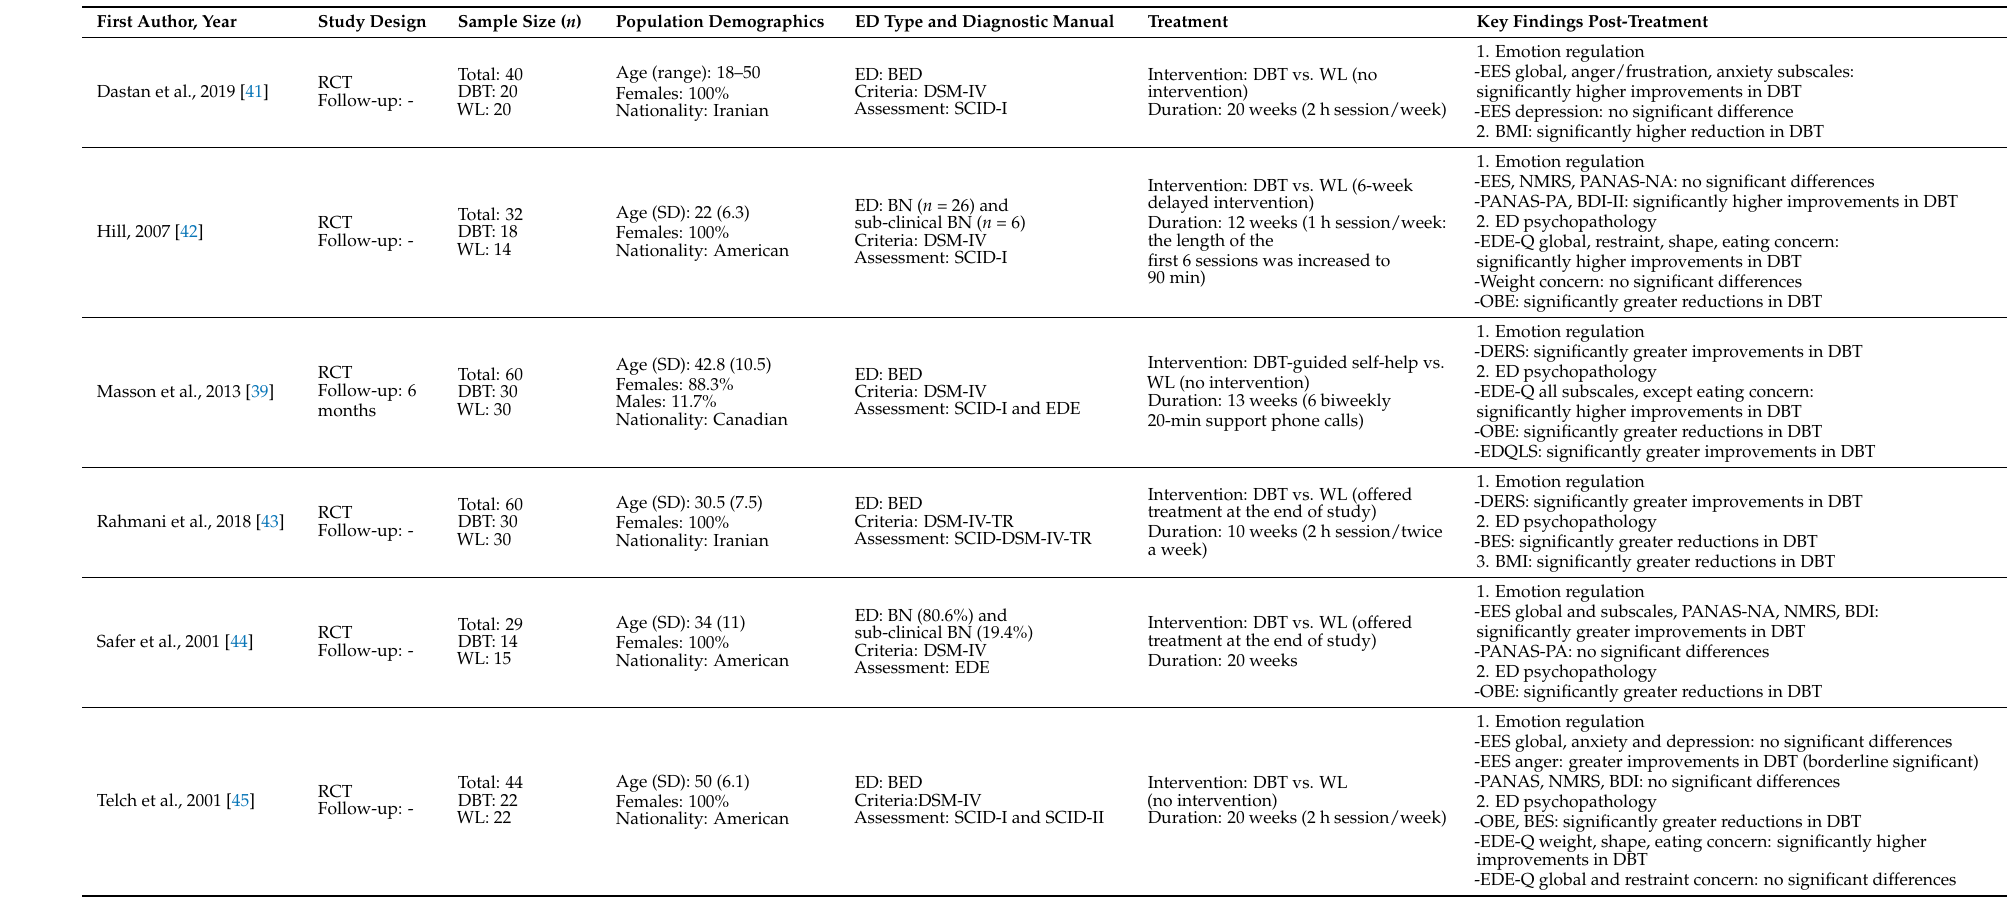
Table 1. Characteristics of the included studies (DBT vs.